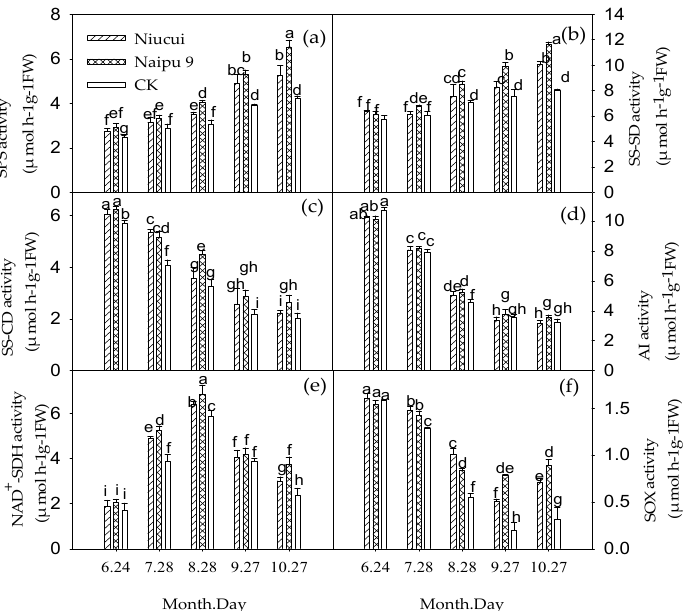
Figure 4. Effects of spraying calcium fertilizer on ( a ) SPS activity, ( b ) SS − SD activity, ( c ) SS − CD activity, ( d ) AI activity, ( e ) NAD − SDH activity, and ( f ) SOX activity of apple fruit. The values represent mean ± S.E. of three replicates. Bars indicate S.E. Bars with the same letter were not significantly different, at p < 0.05.